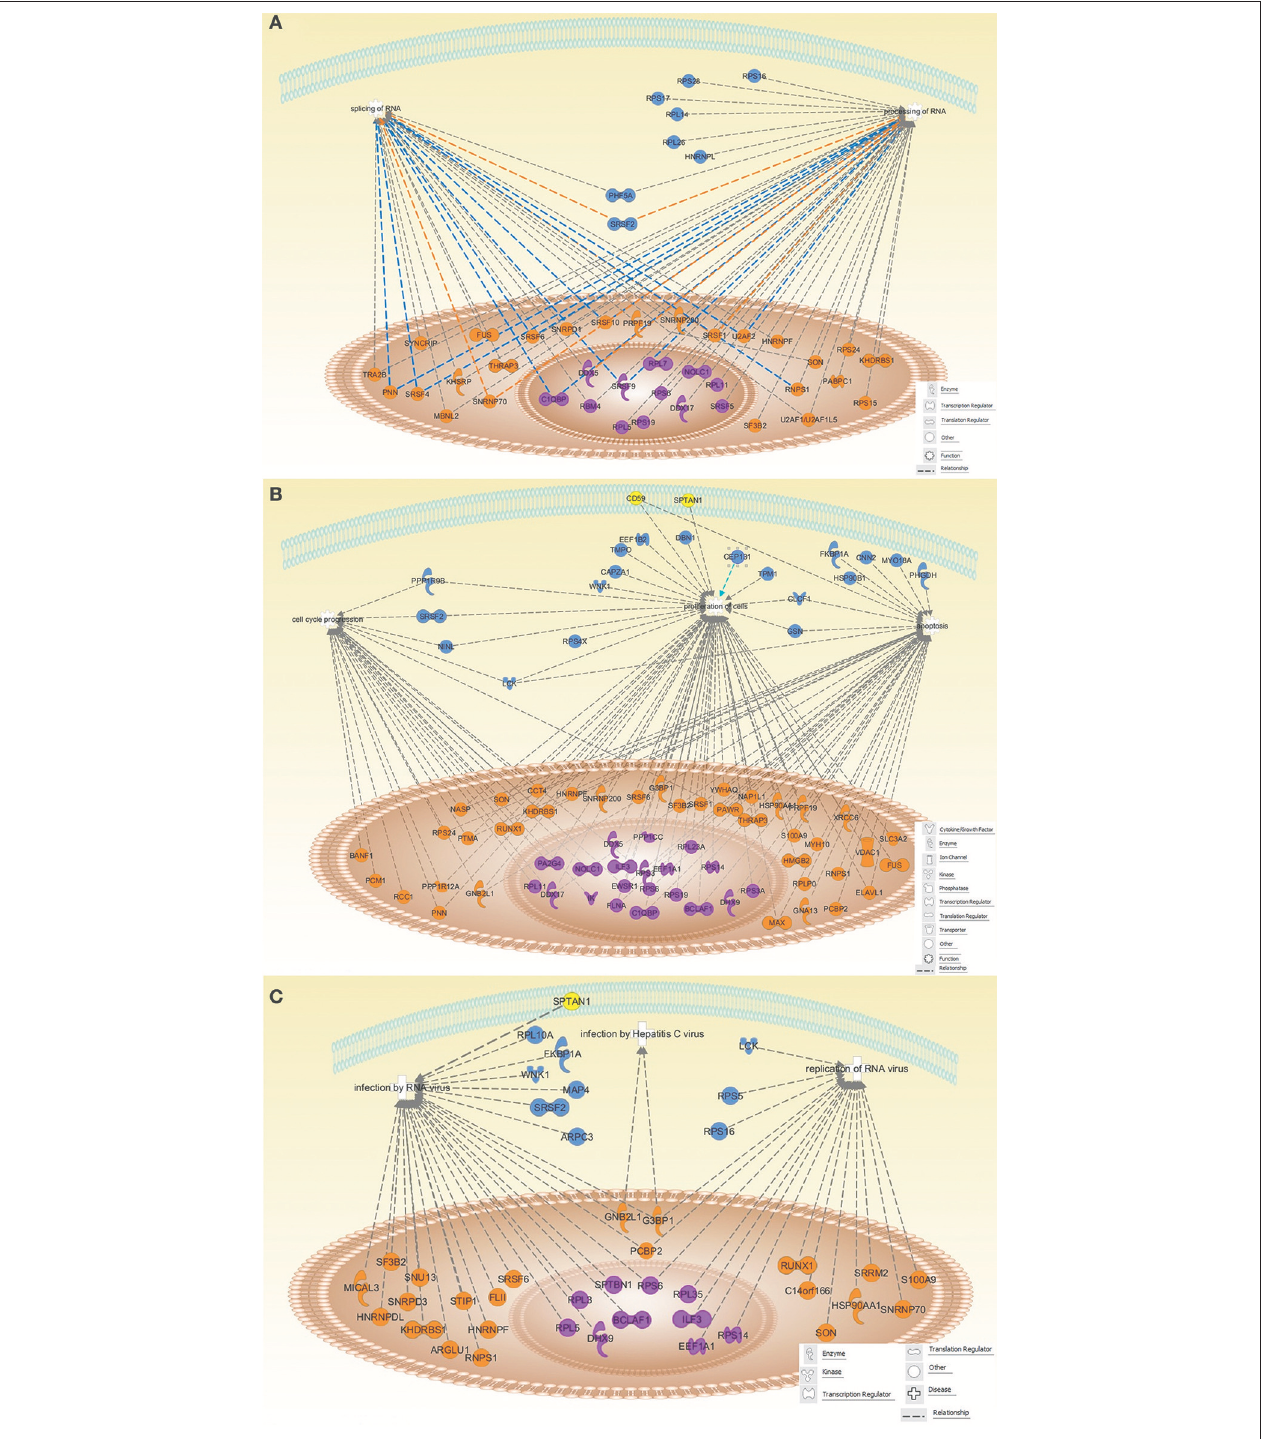
FIGURE 3 | Schematic representation of the identified proteins involved in different top networks categories. The identified proteins were associated with splicing and processing of RNA (A) ; cell cycle progression, proliferation and apoptosis (B) ; infection by RNA viruses, replication of RNA viruses and Hepatitis C virus infection (C) . Protein shapes indicate their function. Proteins are localized in the nucleus (orange), nucleolus (violet), cytoplasm (blue), and plasma membrane (yellow), according to String 10 Go Cellular component. All the relationship lines are supported by at least one reference from the literature, textbooks or canonical information stored in the Ingenuity Knowledge